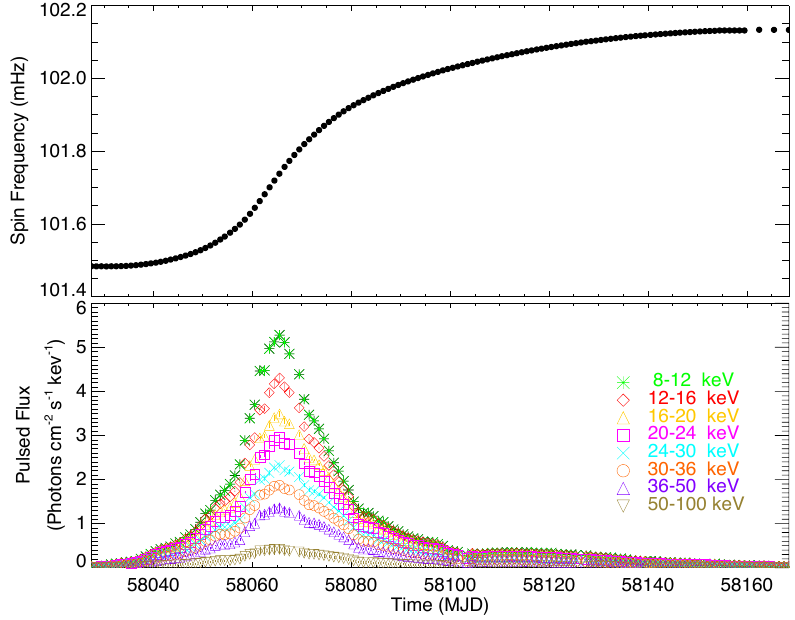
Figure 9. ( Top ): Barycentered and orbit-corrected spin-frequency history of Swift J0243.6+6124 measured with GBM. ( Bottom ): Pulsed flux measured with GBM in nine energy bands [36]. ( c (cid:13) AAS. Reproduced with